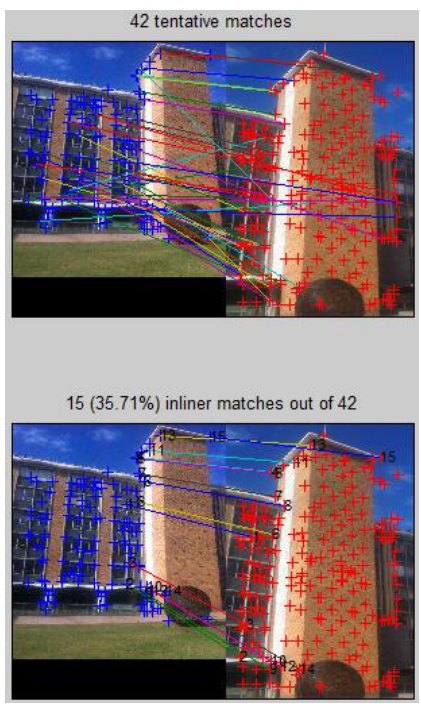
Figure 13. Query image matching with reference image No. 15 using Harris/SIFT method; Harris corner features are tagged by blue and red crosses respectively, and matched corner features using SIFT descriptor matching are shown by